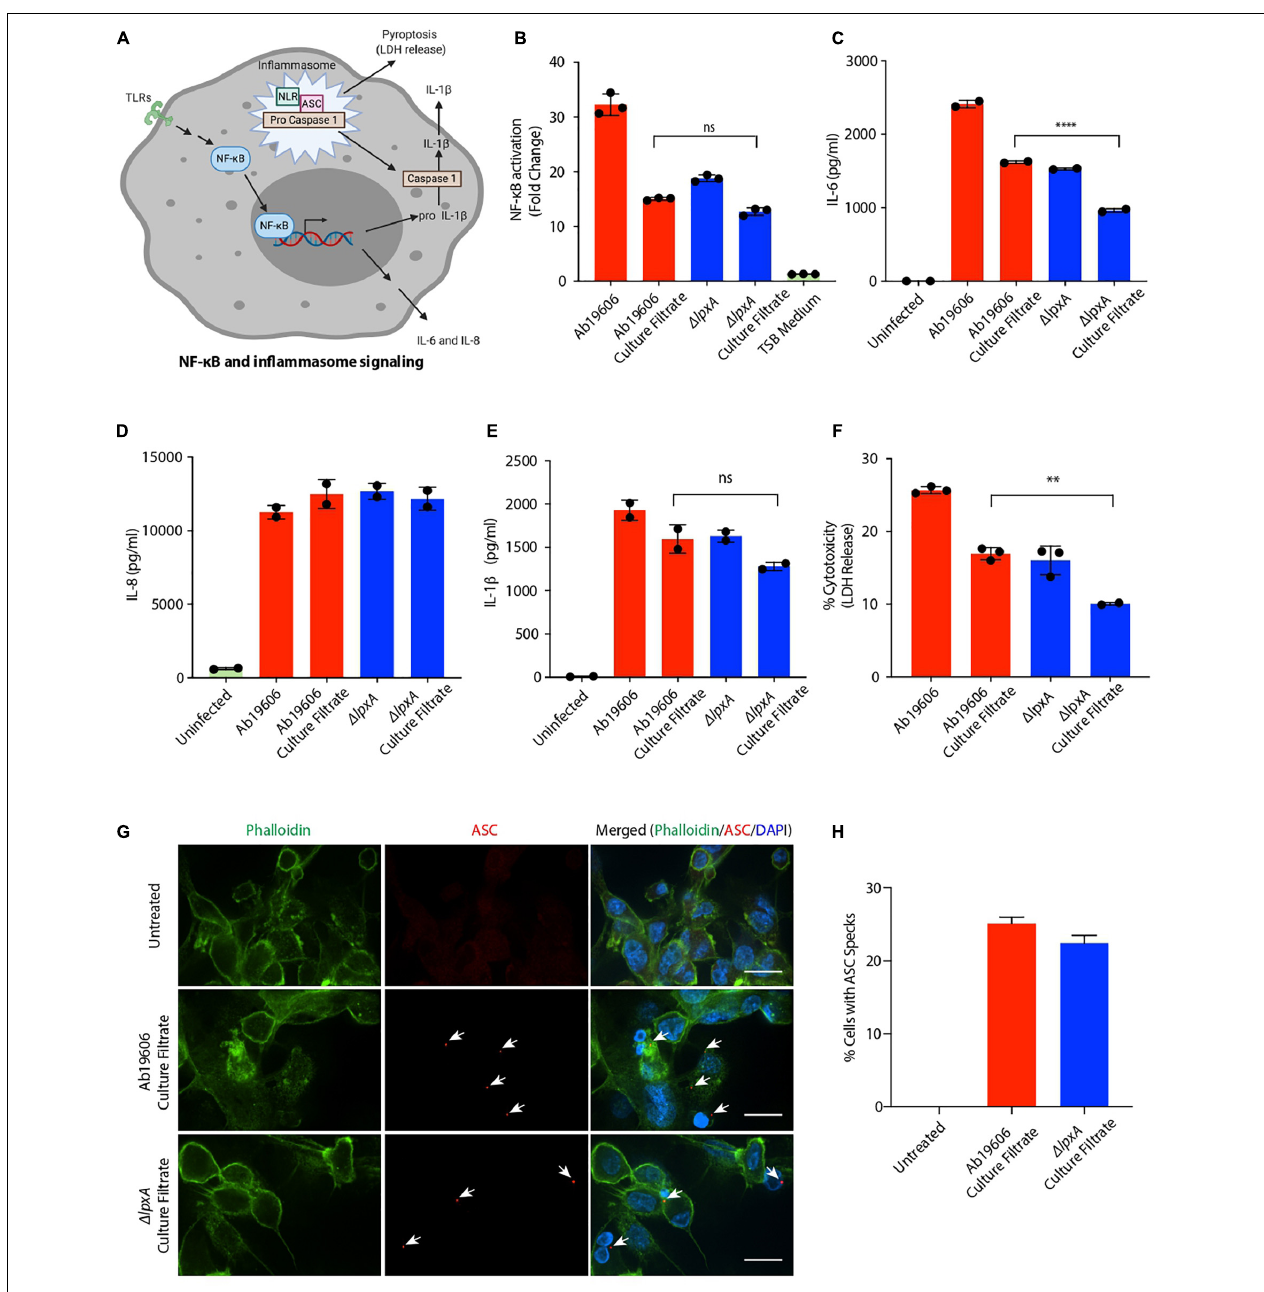
FIGURE 2 | Acinetobacter baumannii secretes factors that activate inflammatory signaling and pyroptosis. (A) Schematic depicting the NF- κ B and the inflammasome signaling pathways; TLRs – Toll-like receptors, NLR – Nod-like receptor (created with BioRender.com). (B) THP1-XBlue reporter cells were infected with wildtype A. baumannii (Ab19606) and (cid:49) lpxA at MOI 10 or treated with the respective culture filtrates. Levels of SEAP were assessed after 24 h of infection or culture filtrate treatment. The experiments were done in triplicates. Error bars represent standard deviation. One-way ANOVA with Tukey’s multiple comparisons test. (C–E) THP1 macrophages were infected with wildtype A. baumannii (Ab19606) and (cid:49) lpxA at MOI 10 or treated with the respective culture filtrates. Levels of IL-6, IL-8 and IL-1ß in the cell culture supernatant after 24 h of infection or culture filtrate treatment were assessed by ELISA. The experiments were done in triplicates. Error bars represent standard deviation. One-way ANOVA with Tukey’s multiple comparisons test ns – not significant. (F) THP1 macrophages were infected with wildtype A. baumannii (Ab19606) and (cid:49) lpxA at MOI 10 or treated with the respective culture filtrates. LDH levels in the cell culture supernatant were assessed after 24 h of infection or culture filtrate treatment. The experiments were done in triplicates. Error bars represent standard deviation. One-way ANOVA with Tukey’s multiple comparisons test. (G) THP1 macrophages were treated with the indicated culture filtrates for 6 h. The cells were then fixed and immunofluorescence was performed to detect ASC specks using an anti-ASC antibody. Arrowheads indicate ASC specks. The scale bars represent 20 µ M. (H) The graph represents % cells with ASC specks relative to the total number of cells counted in the indicated treatments. All the experiments were performed three times independently. * P < 0.05, ** P < 0.01, *** P < 0.001, **** P <